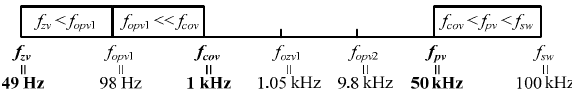
Figure 14. Frequency point setting of charge voltage loop.